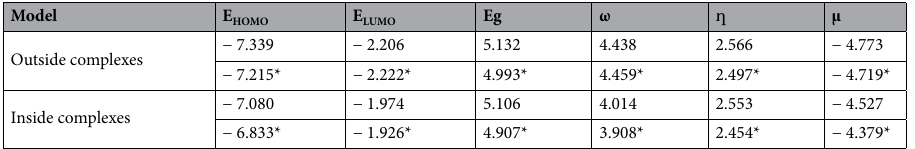
Table 3. Calculated energies of frontier molecular orbitals (EHOMO, ELUMO, eV), HOMO–LUMO band gap (Eg, eV), chemical potential (μ, eV), global hardness ( ƞ , eV) and global electrophilicity index (ω, eV) of the studied systems. *In water